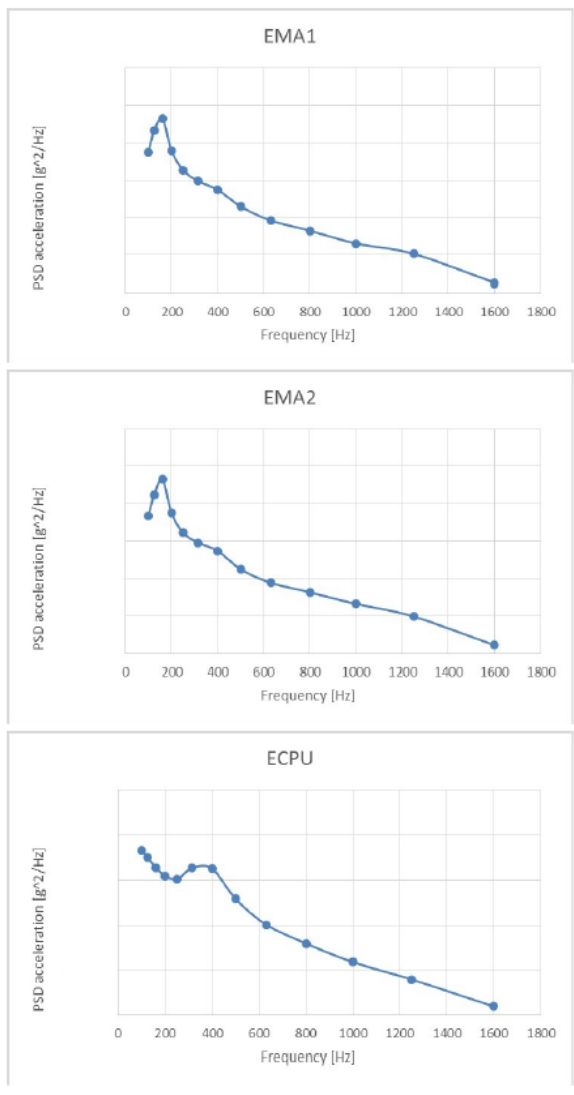
Figure 5. Accelerations calculated for some equipment in the IS01